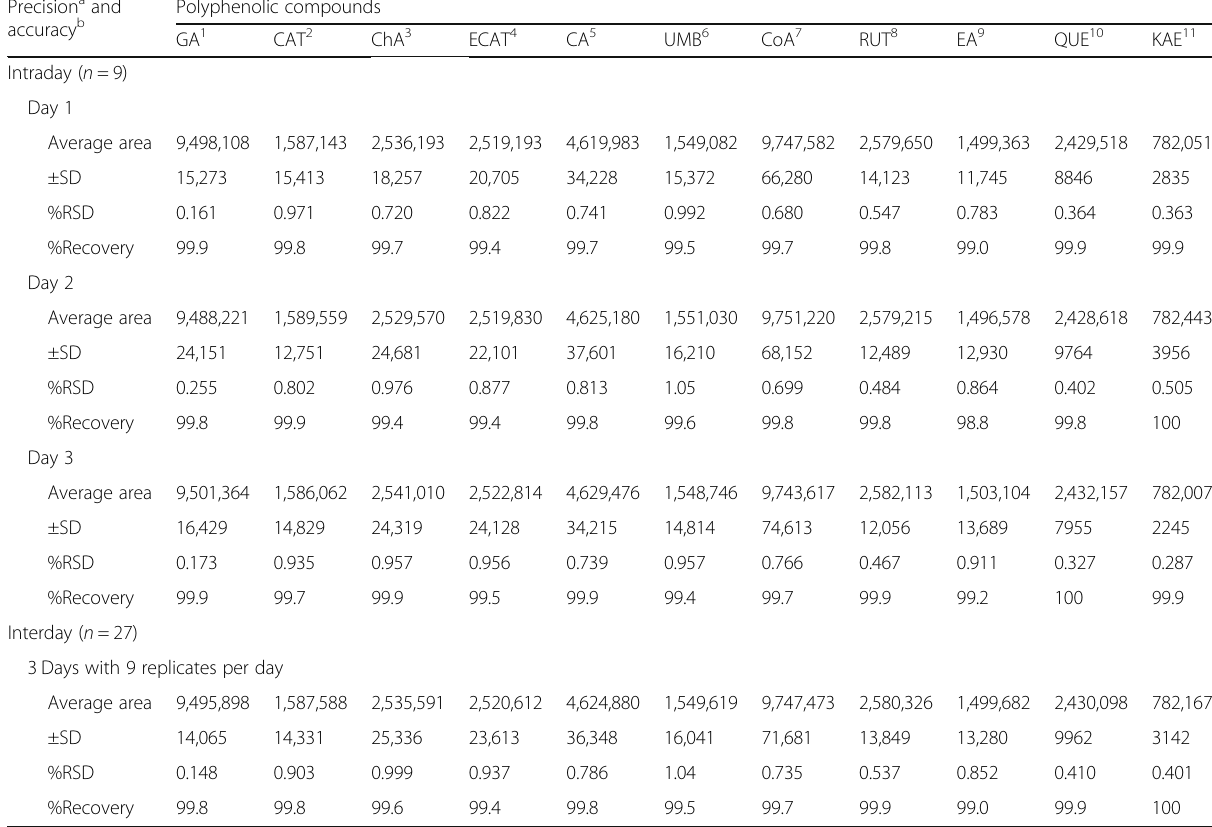
Table 5 Intraday and interday precision and accuracy of HPLC-PDA method with mixture of polyphenolic compounds injected at highest concentration Precision a and accuracy